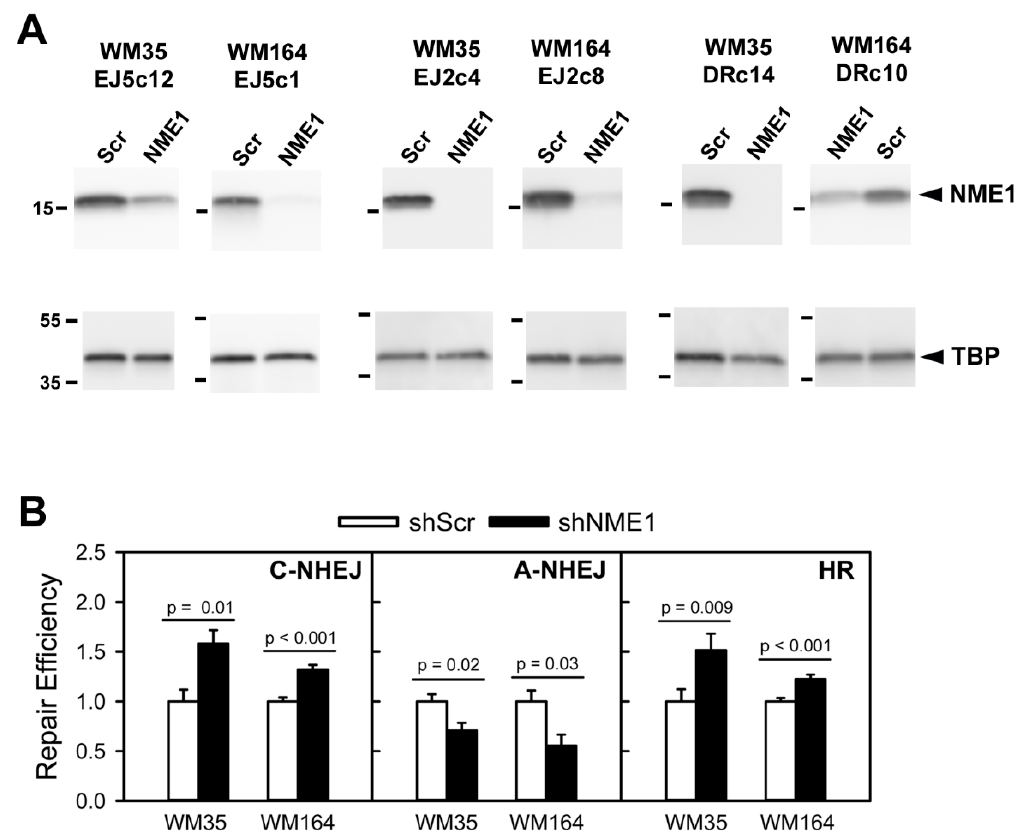
Figure 4. NME1 suppresses non-homologous end-joining (NHEJ) and homologous recombination (HR) in melanoma cells, while upregulating alternative NHEJ (A-NHEJ). Intra-chromosomal assays for NHEJ, HR and NHEJ were conducted in the human melanoma cell lines WM35 and WM164, with individual clones harboring one of the following stably integrated repair cassettes: EJ5-GFP (NHEJ), EJ2-GFP (A-NHEJ), or DR-GFP (HR). Cells were infected for 24 h with lentivirus encoding either a scrambled shRNA sequence (Scr) or an shRNA directed to NME1 (NME1), followed by induction of double-stranded DNA breaks by transient transfection with a plasmid encoding the homing endonuclease I-SceI. Repair activity (% GFP-positive cells) was measured 72 h post-transfection using flow cytometry (> 10,000 cells analyzed per condition). ( A ) Validation of shRNA-mediated silencing of NME1 in melanoma cell lines. Immunoblot analysis of NME1 (upper panels) and TATA-binding protein (TBP, lower panels) expression in the indicated clones was conducted 96 h after infection with lentiviruses expressing either scrambled shRNA or shRNA directed to NME1. Cells for immunoblot analysis were infected in parallel with those used in the repair assays of panel B. Mobilities of NME1 and TBP are identified at the far right. ( B ) Differential regulation of NHEJ, A-NHEJ and HR by NME1. Data are represented as mean repair activity normalized for each clone against cells treated with shScr-expressing lentivirus. NHEJ assays were conducted in clones WM35EJ5c12 and WM164EJ5c1 (N = 8 from two replicate experiments for both clones), A-NHEJ assays in clones WM35EJ2c4 (N = 12 from 3 replicate experiments) and WM164EJ2c8 (N = 4), and HR assays in clones WM35DRc14 (N = 12 from three replicate experiments) and WM164DR10 (N = 16 from 4 replicate experiments). All experiments were conducted with quadruplicate wells for each treatment group. Detailed methods for generation of stably transfected clones, intra-chromosomal assays of NHEJ, A-NHEJ and HR activity, and statistical analyses are provided in Experimental Procedures. Original full-length images of scanned immunoblot membranes in panel A are shown in Figure S1.